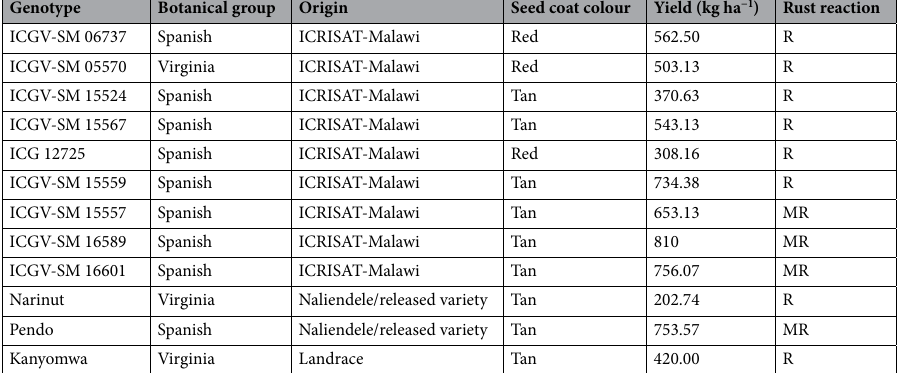
Table 2. Description of groundnut parents used in the crosses. ICRISAT International Crop Research Institute for the Semi-Arid Tropics, R resistant, MR moderately resistant.